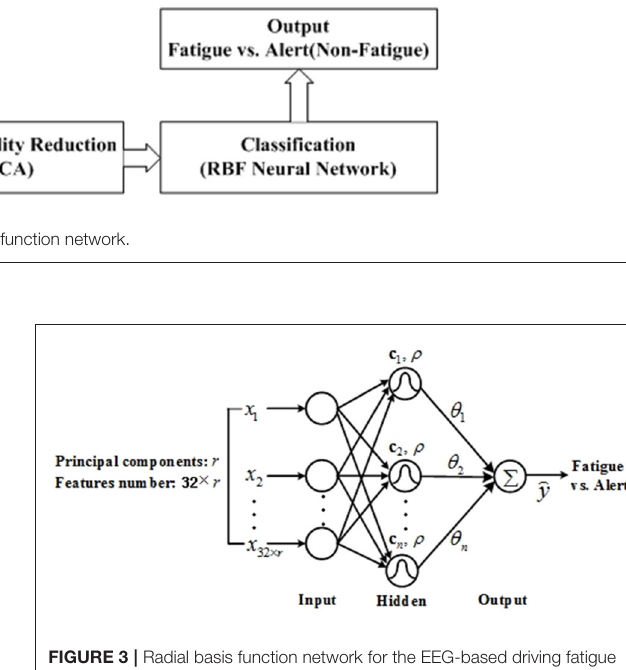
FIGURE 3 | Radial basis function network for the EEG-based driving fatigue classification